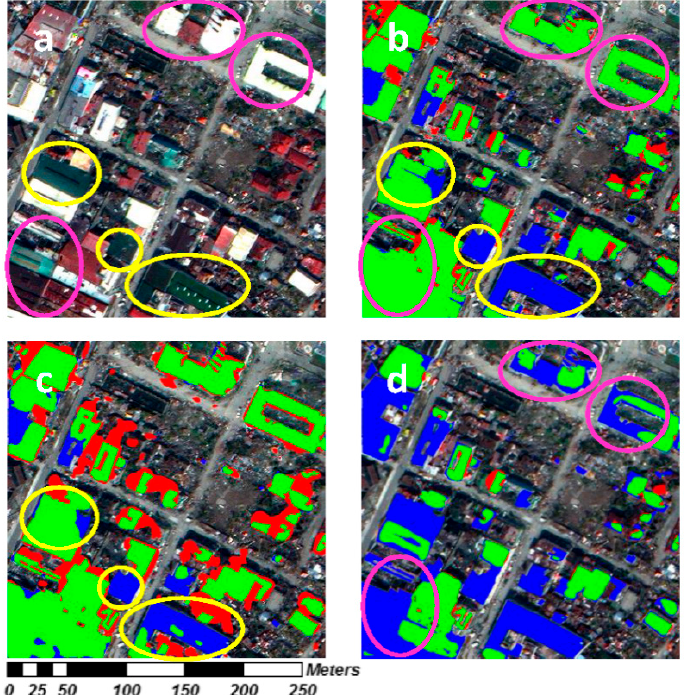
Figure 7. ( a ) Original test image #1, ( b ) ResUnet-CRF, ( c ) ResUnet, and ( d ) ResUnet without fine-tuning results. The areas within the yellow boundaries denote the dark green buildings to stress the effect of the CRF in the final result. The areas within the purple boundaries denote the inaccuracies in the results, which were extracted using the network that was initially trained without fine-tuning. Green, red, and blue pixels represent TP, FP, and FN, respectively.